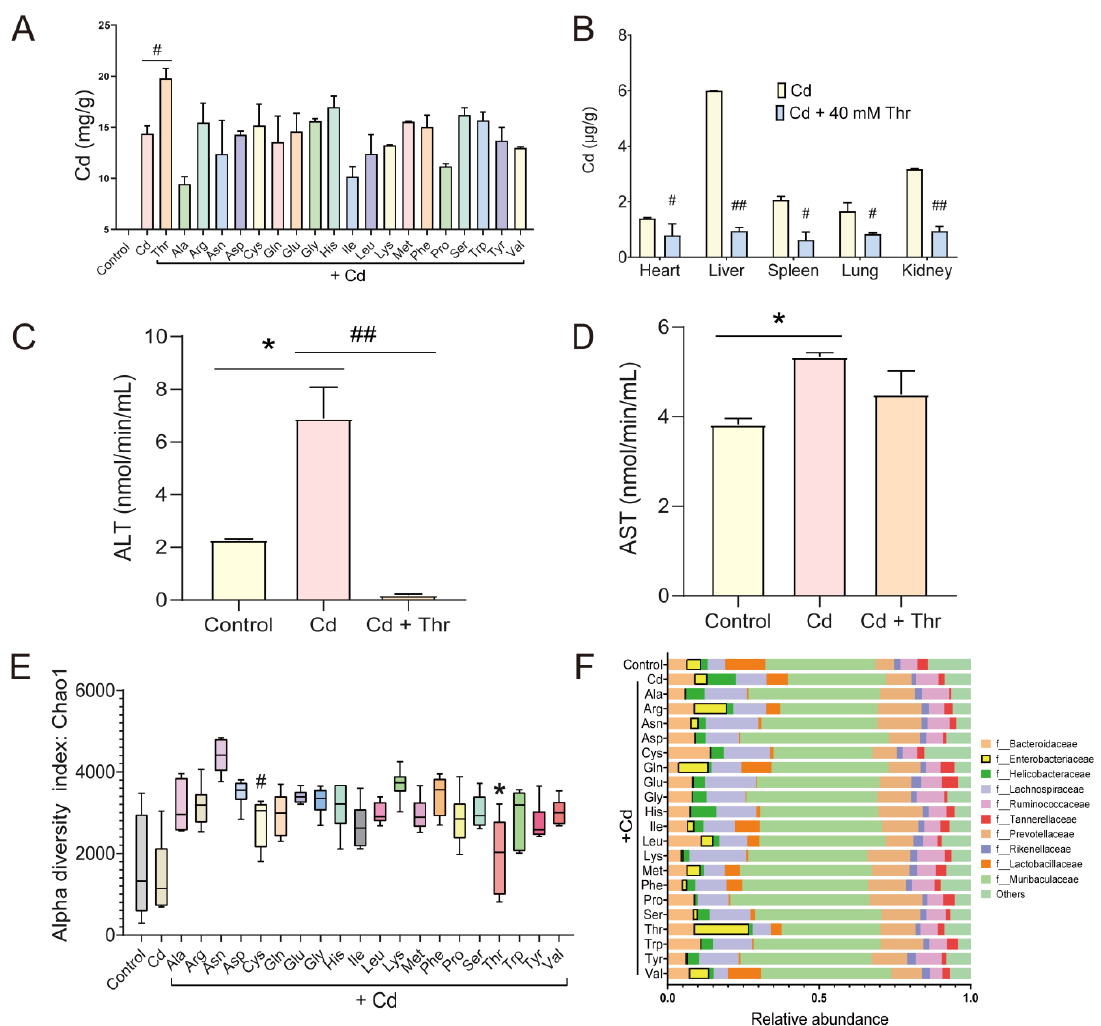
Figure 1. Effects of different amino acids (AAs) on Cd level and gut microbiota (GM) in mice. ( A ) Cd contents in feces. ( B ) Cd contents in tissues. ( C ) Serum alanine aminotransferase (ALT) level. ( D ) Serum aspartate aminotransferase (AST) level. ( E ) The microbiome community richness index Chao of the GM. (F) The relative abundance of the top 10 abundances bacterial phyla at the family level. # p < 0.05, ## p < 0.001 indicate results that differ significantly from the Cd-treated group. * p < 0.05 indicate results that differ significantly from the control group.